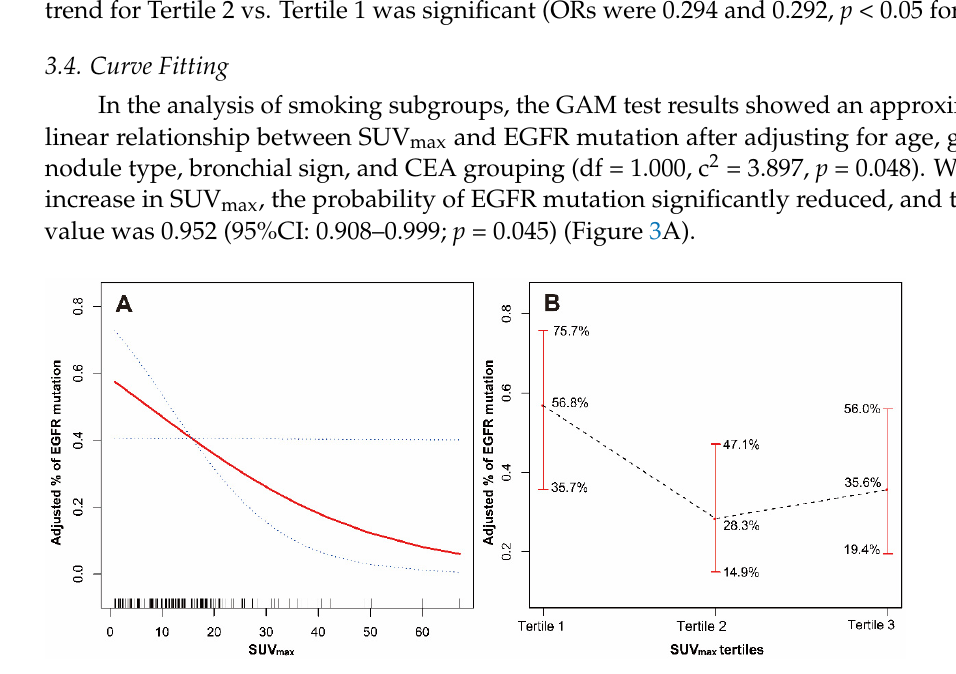
Figure 3. ( A ) The relationship between SUV max and the probability of EGFR mutation (the solid red line indicates the fitted line of the probability of EGFR mutation and SUV max ; the blue dotted line is the 95% confidence interval; adjusted for age and CEA grouping). ( B ) The relationship between SUV max tertiles and the probability of EGFR mutation (the black dotted line indicates the fitted line of the probability of EGFR mutation and SUV max tertiles; the red line is the 95% confidence interval; adjusted for age and CEA grouping).